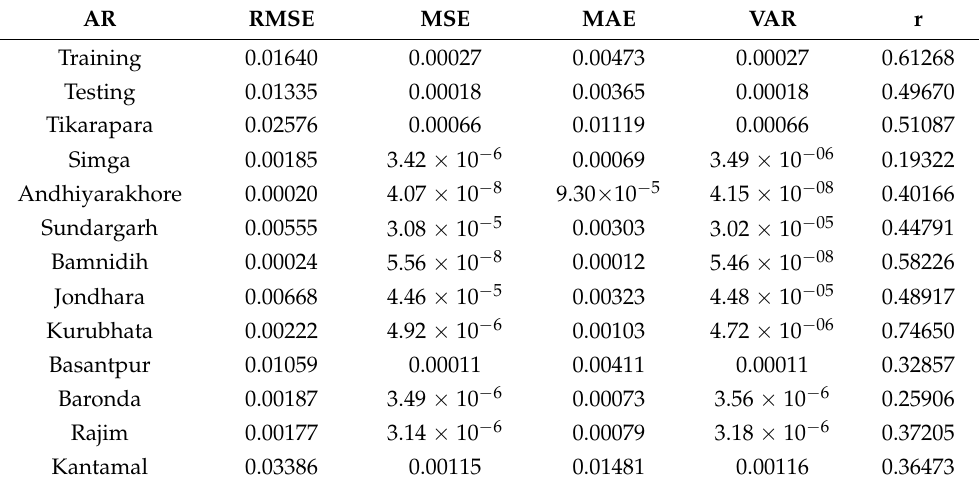
Table 6. Error statistics of the autoregressive (AR) forecasting model at different gauging stations. AR RMSE MSE MAE